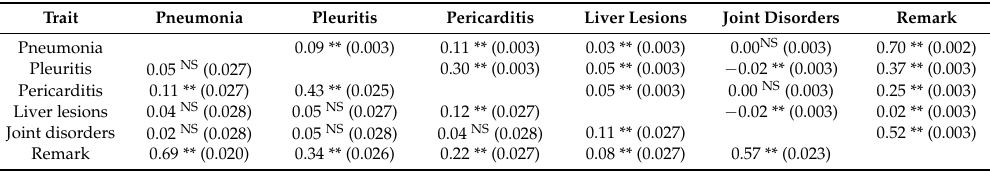
Table 4. Estimates of genetic and phenotypic corrections among slaughter remarks. Phenotypic correlations above diagonal, genetic correlations below diagonal.